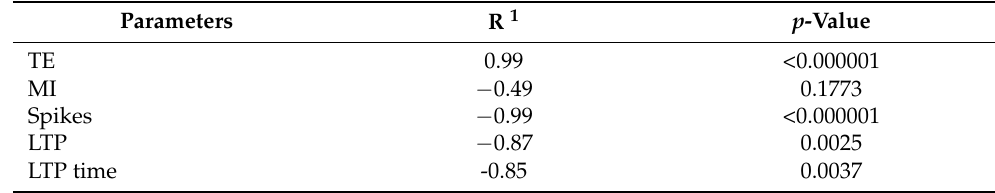
Table 3. Correlation analysis of transfer entropy (TE), mutual information (MI), spikes, LTP, and LTP time in memantine treatment